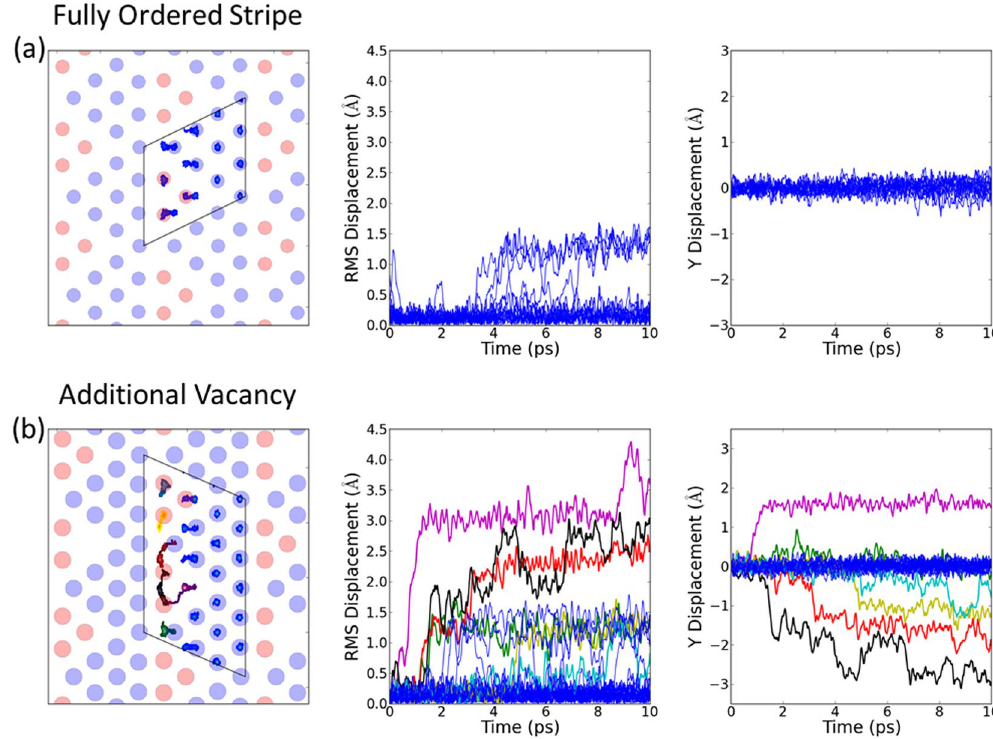
Figure 3. Molecular dynamics simulation of diffusion in Na 0.8 CoO 2 in the stripe phase. The left-hand panel shows the trace of sodium positions over the duration of the simulations (the boxes show the cells used in the MD simulations), the middle panel shows the root-mean-square displacement of individual sodium ions from their initial sites as a function of time, and the right-hand panel shows displacements along the stripe direction. The different colours give trajectories for different ions, with the same colour for a given ion in successive panels from left to right. The simulations were performed at T ~ 350 K for the tri-vacancy stripe phase ( a ) fully ordered and ( b ) with an additional vacancy on a 2 b site. For the ideal superstructure there are local hops back and forth between 2 d and 2 b sites perpendicular to the stripe, but there is no bulk self-diffusion. The introduction of additional disorder in the stripes results in multiple hops between 2 d and 2 b sites with components along the stripes. Chains of hops of different ions results in dynamic irreversibility and self-diffusion along the